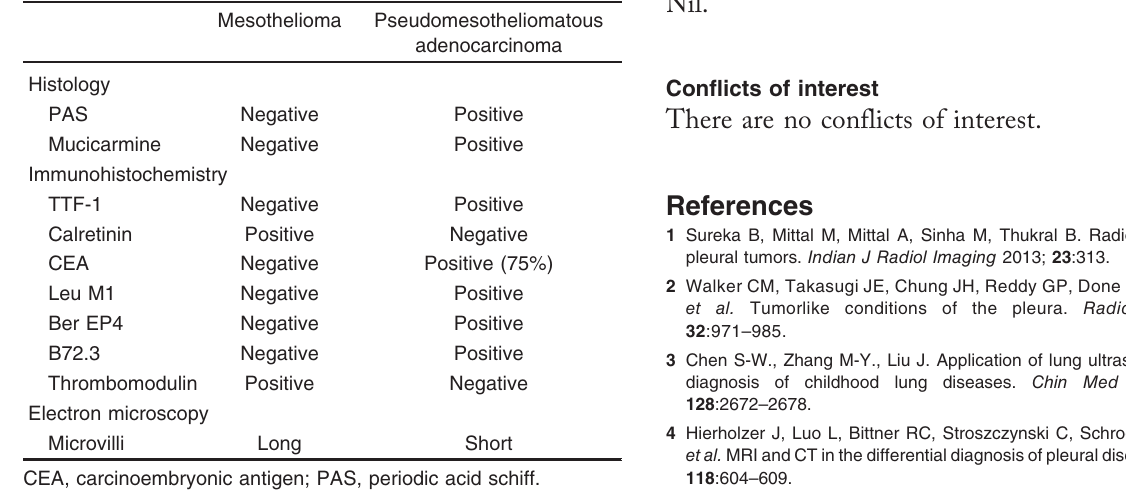
Table 2 Histopathology and immunohistochemistry features to differentiate mesothelioma and pseudomesotheliomatous